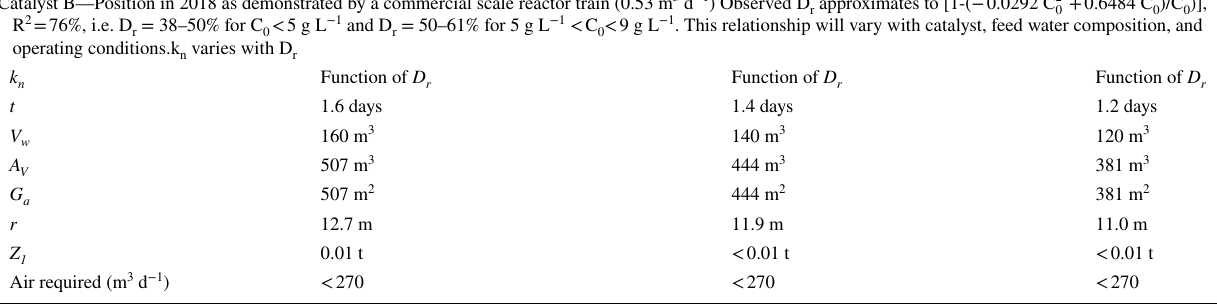
cfm cubic feet/minute. Quartile analyses are based on the probability distributions associated with k n